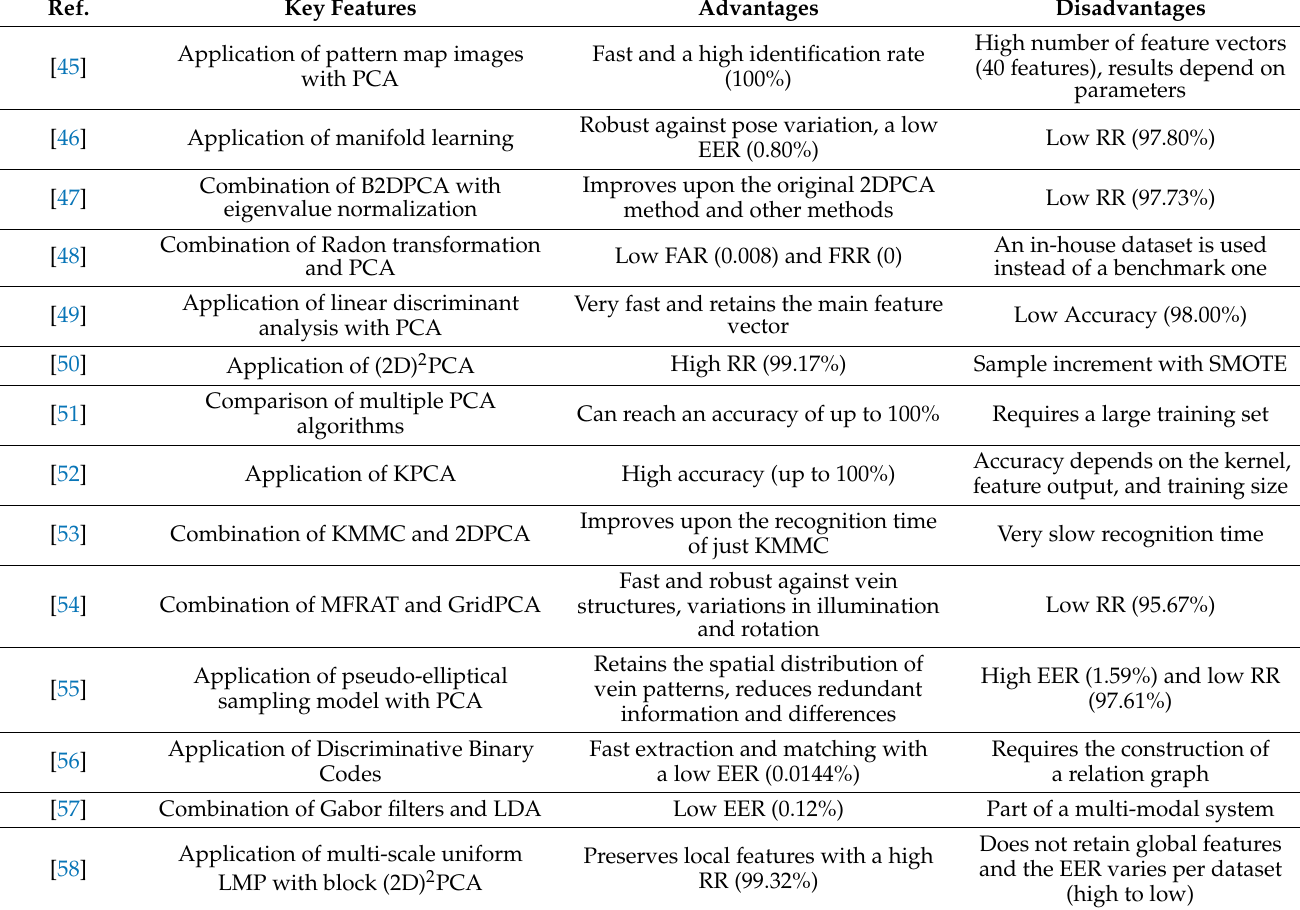
Table 2. Characteristics of the dimensionality-reduction-based feature extraction methodologies.